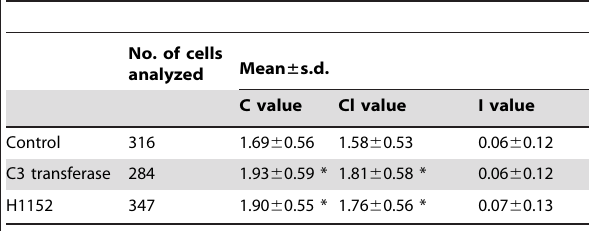
Table 4. Centrosome behavior after RhoA or ROCK inhibition in p53 -/- MEF cells with extra centrosomes.